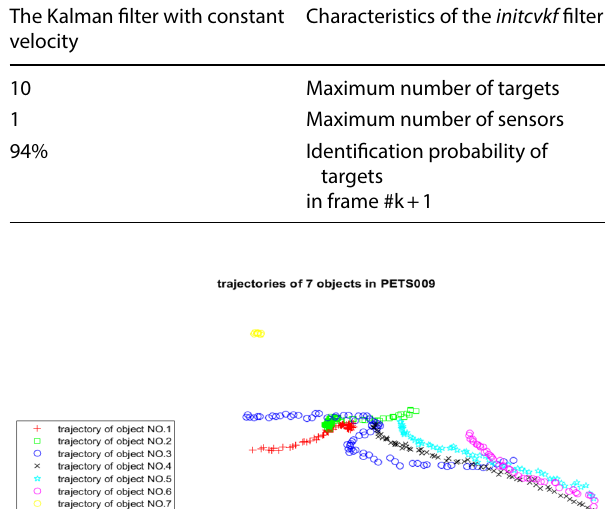
Table 4 Initialization of the JPDA filter parameters The Kalman filter with constant velocity